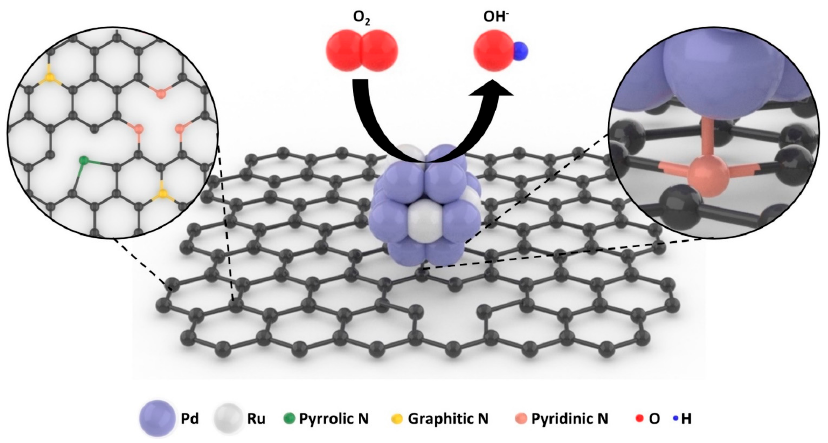
Figure 1. Schematic illustration of the Pd 4.7 Ru NPs/NrGO.